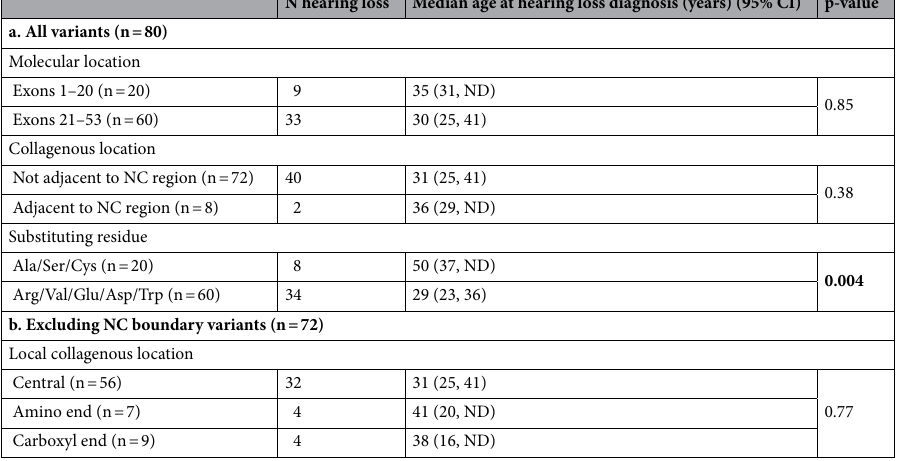
Table 2. Median age at hearing loss diagnosis of COL4A5 Gly missense variants reported in LOVD for each molecular characteristic. NC, non-collagenous; ND, not done (too few data); 95% CI, 95% confidence interval. Significant values are in bold.